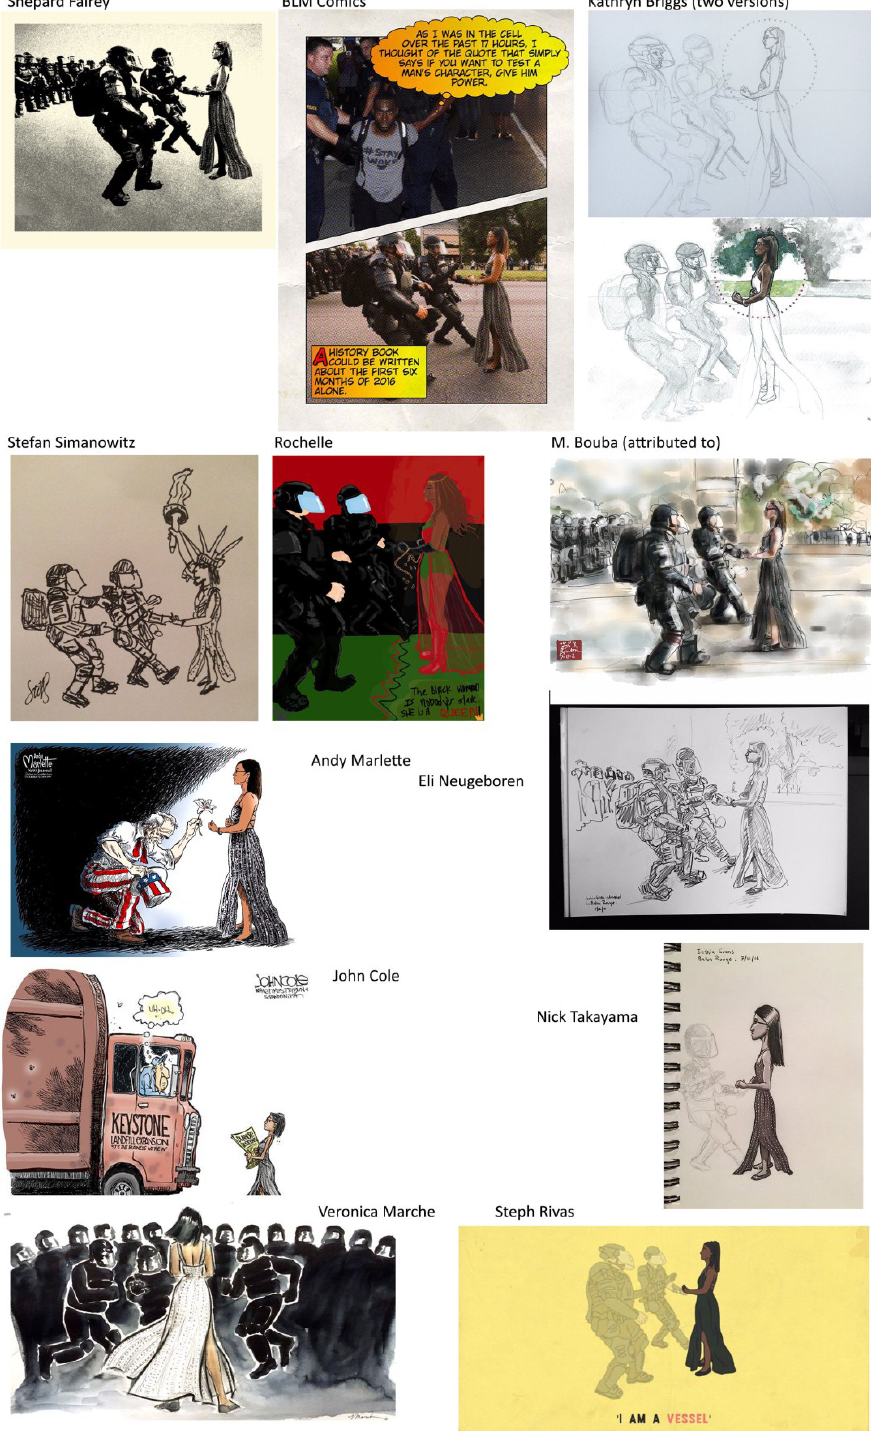
Figure 7. Artistic mediations. Source: Twitter.